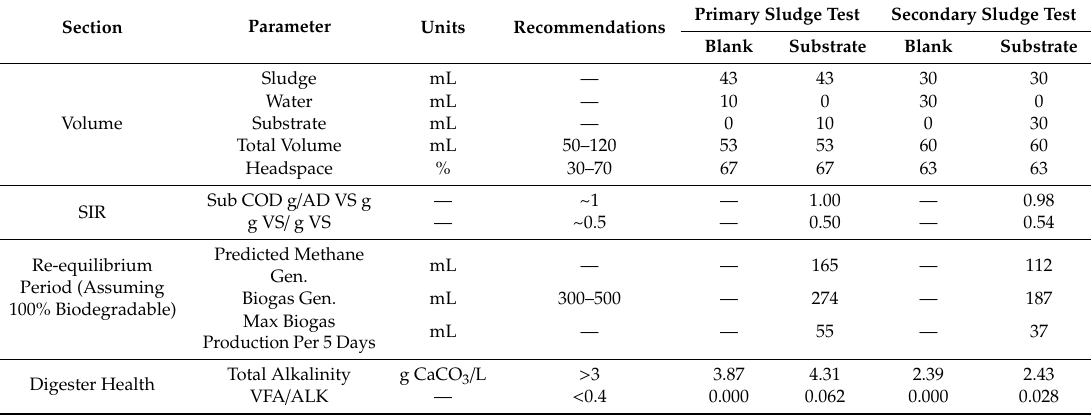
Table 5. BMP test design for primary and secondary sludge from the GWWTP.